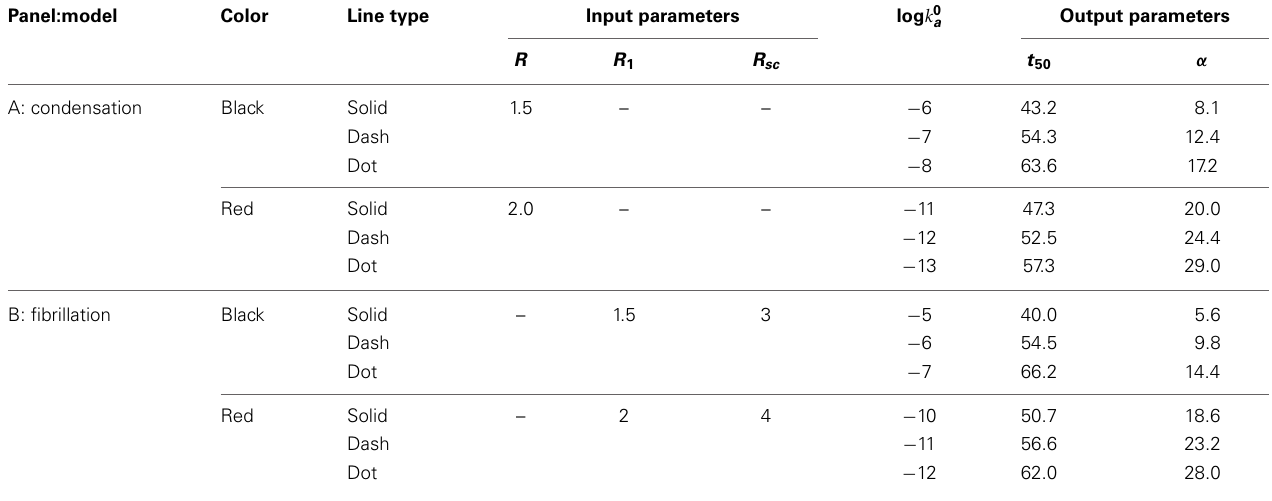
Table 1 | Input and output parameters characterizing each simulation plotted in Figures